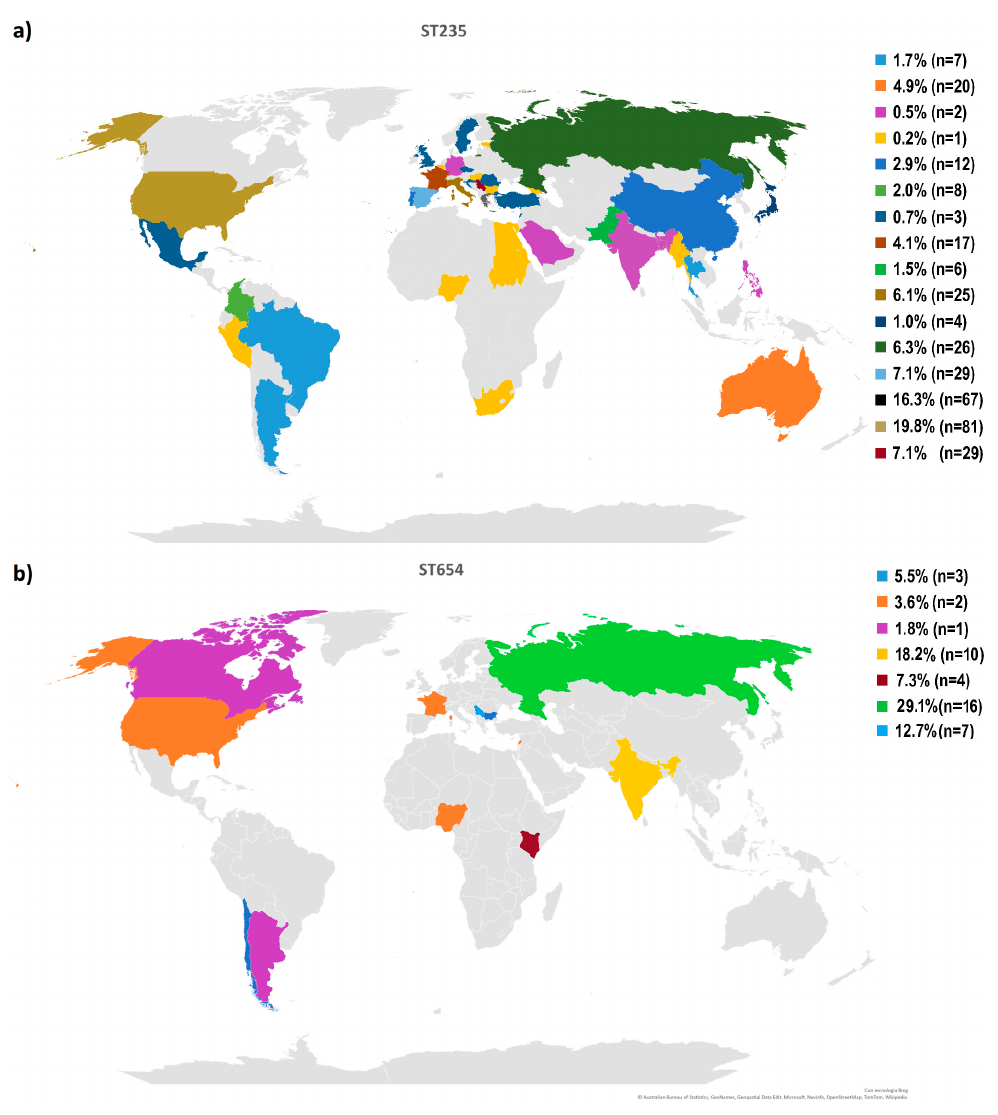
Figure 3. Geographical distribution of the Pseudomonas aeruginosa ST235 ( a ) and ST654 ( b ) high-risk clones based on the data available in the Pseudomonas Genome Database (Date accessed 2 January 2023). Colors represent the percentage of clones ST235 and ST654 among isolates of P. aeruginosa within a country, as indicated in the geographic map.